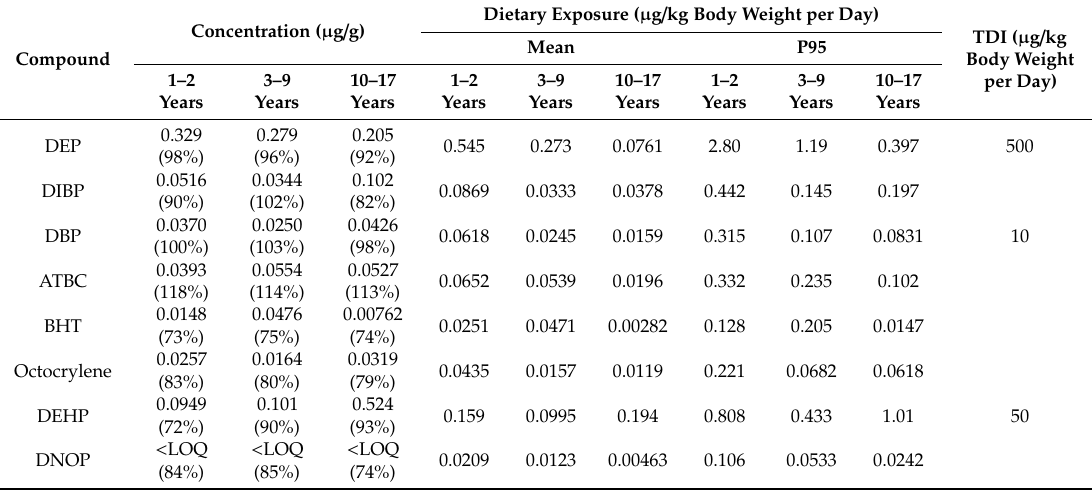
Table 5. Concentration of target migrants in composite food samples with the recovery data and estimated dietary exposure (mean, P95) in Spanish child and adolescent population. Concentration ( µ g / Compound